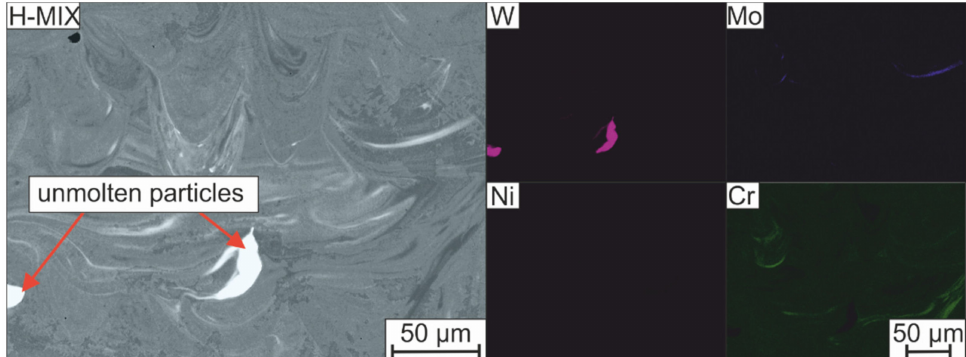
Figure 15. Qualitative studies on the distribution of selected chemical elements in the H-MIX sample using EDS mappings on the left side. Right side shows the area in back scatter electrons (BSE)